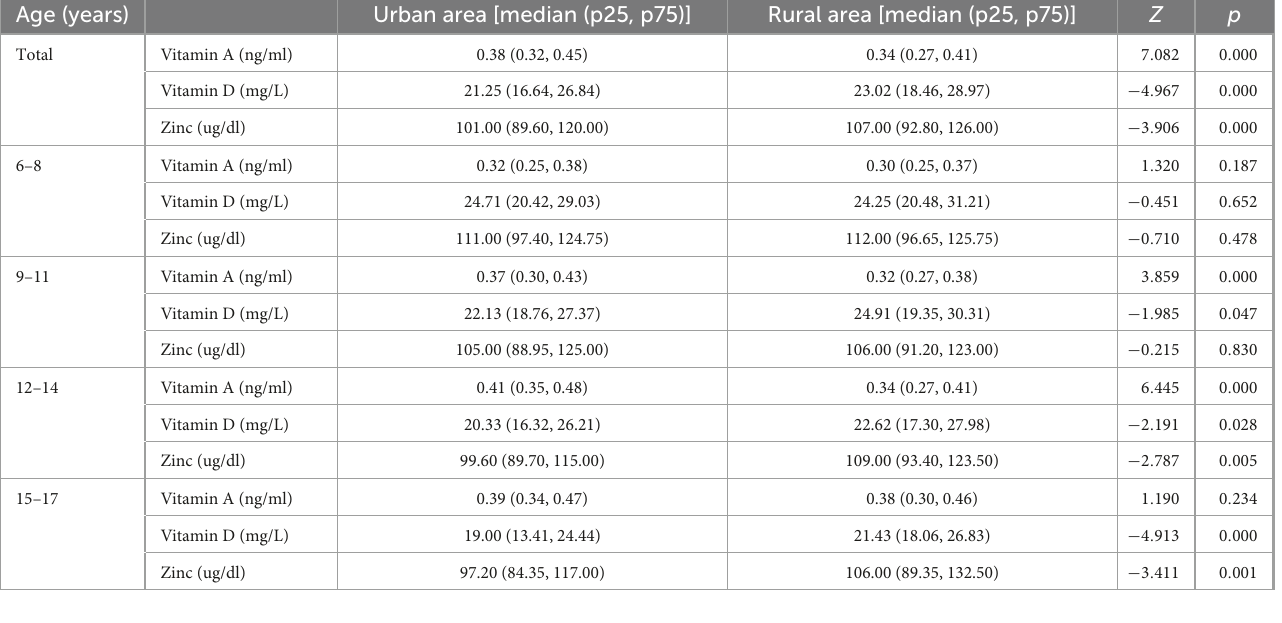
TABLE 1 Serum vitamin A, D and serum zinc median concentration of urban and rural children and adolescents.